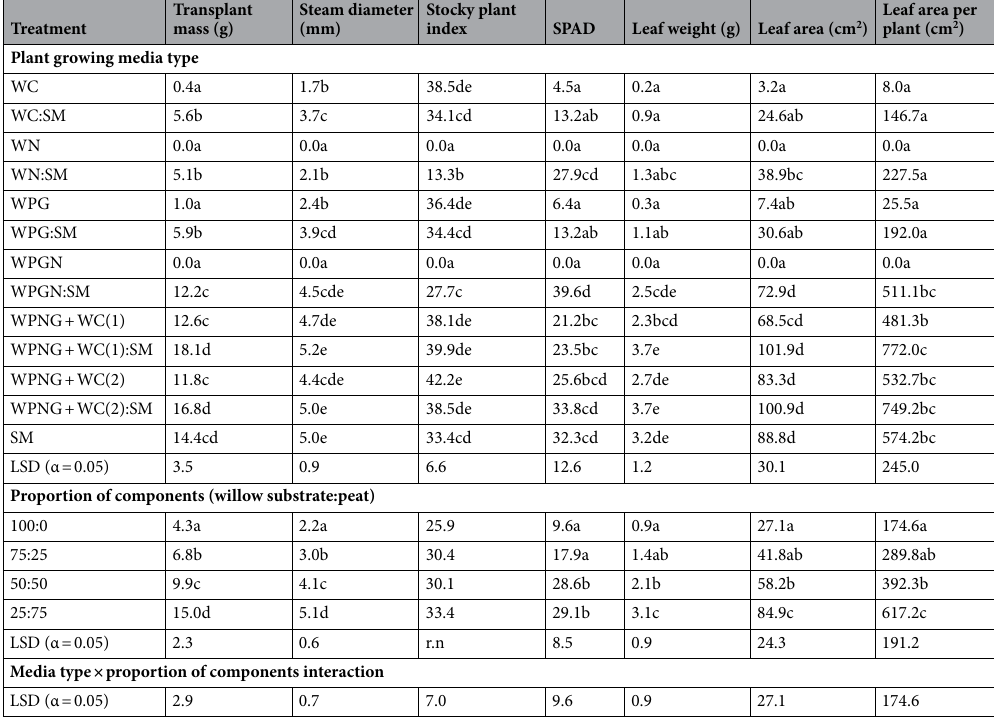
Table 3. The effects of horticulture media and components proportion on tomato transplant